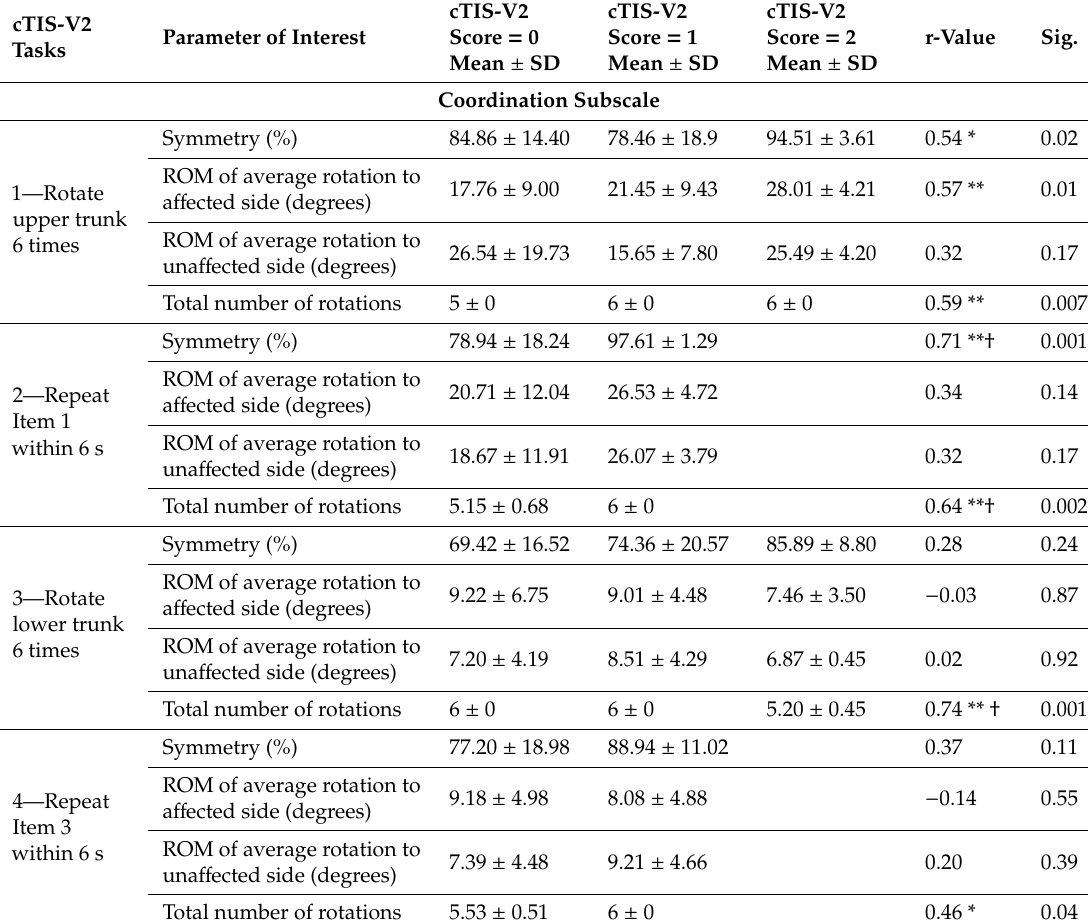
Table 4. Spearman rank correlation of iTIS data with cTIS-V2 score (coordination subscale) in stroke